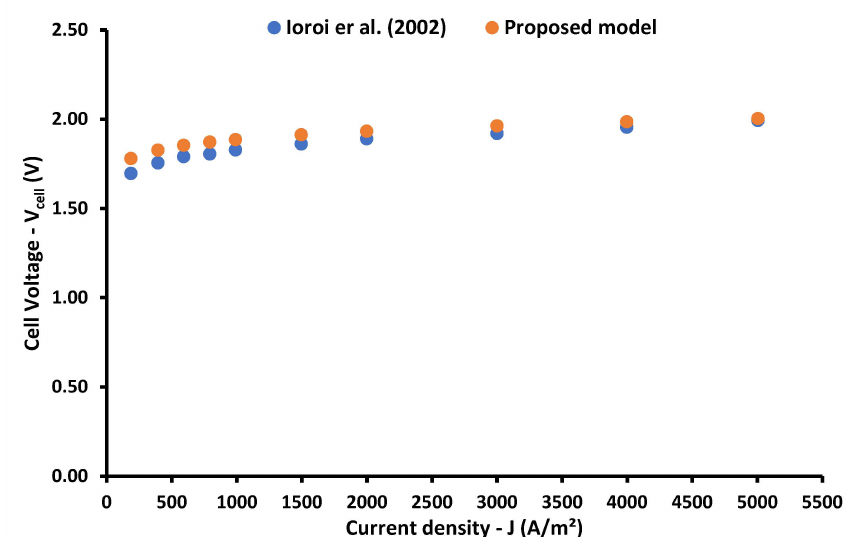
Figure 3. Validation of the PEM water electrolyzer model with experimental data from the litera- ture